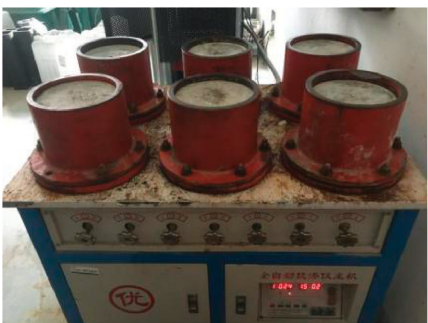
Figure 8: Permeability test